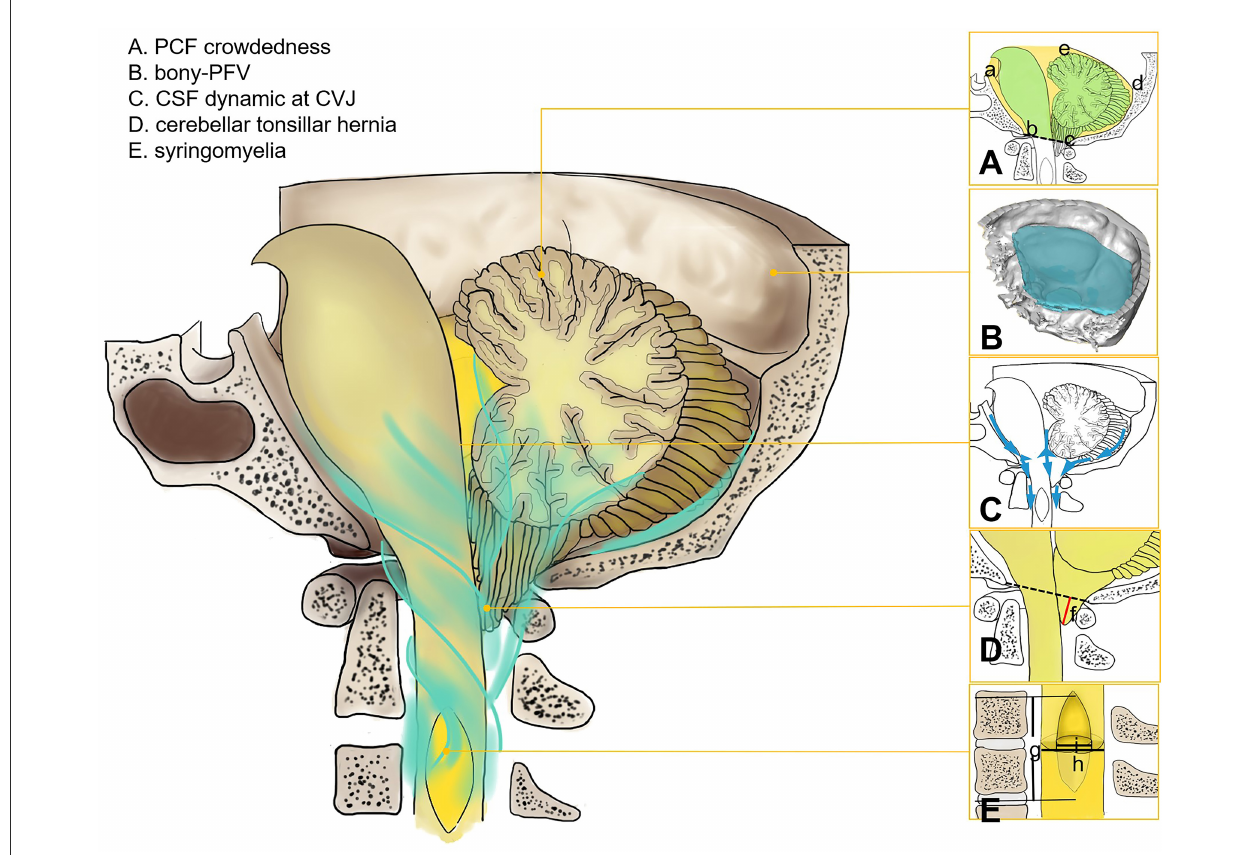
FIGURE1 Morphology and physiological parameters of CSF at CVJ in Chiari malformation I. (A) PCF crowdedness, McRae’s line (b–c), and tentorium cerebelli (d–e). The hindbrain area is represented in green, and the PCF area is shown in yellow (a–e). (B) Three-dimensional model of PFV. (C) CSF circulation at CVJ. (D) Cerebellar tonsil descent (f). (E) syrinx length (g), maximum diameter of syrinx (i), and spinal cord diameter